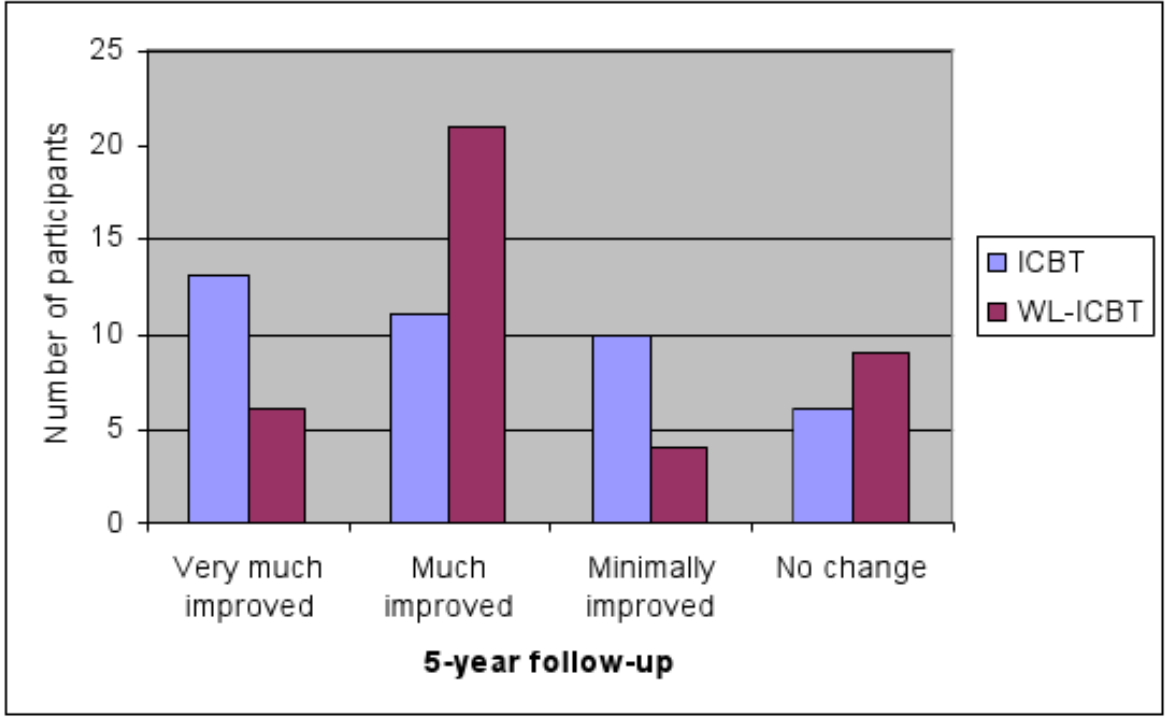
Figure 3. Clinical Global Impression Improvement (CGI-I) scores at 5-year follow-up (dropouts are considered